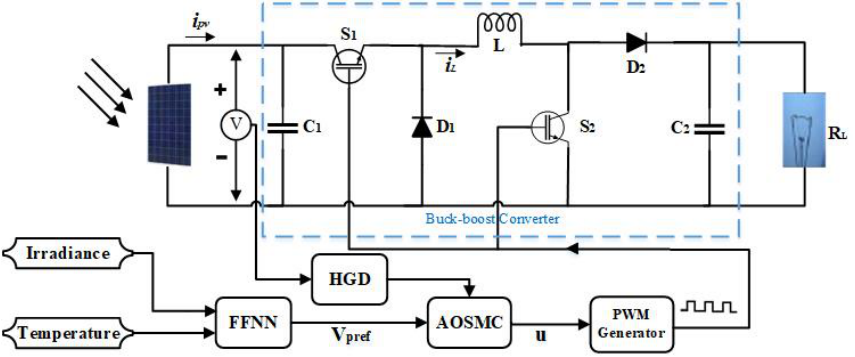
Figure 1. Proposed control methodology.